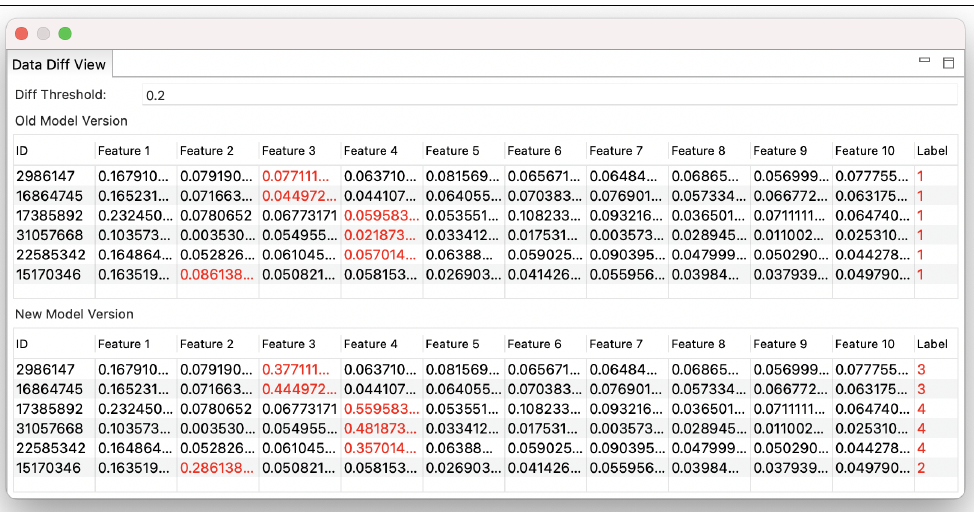
Figure 12. Highlighting the differences between the model